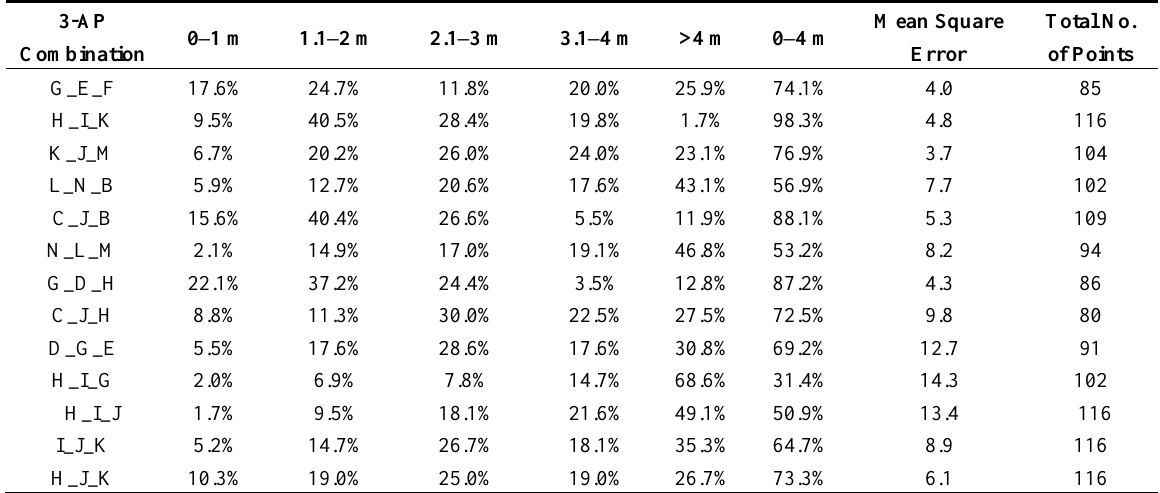
Table 2. Accuracy achievement based on signal reception of three